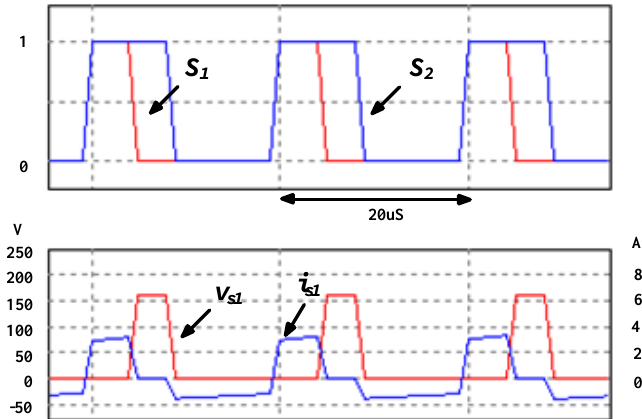
Figure 16. Simulation results for (top) switching control signals and (bottom) corresponding voltage and current of switch S 2 during positive half line cycle.